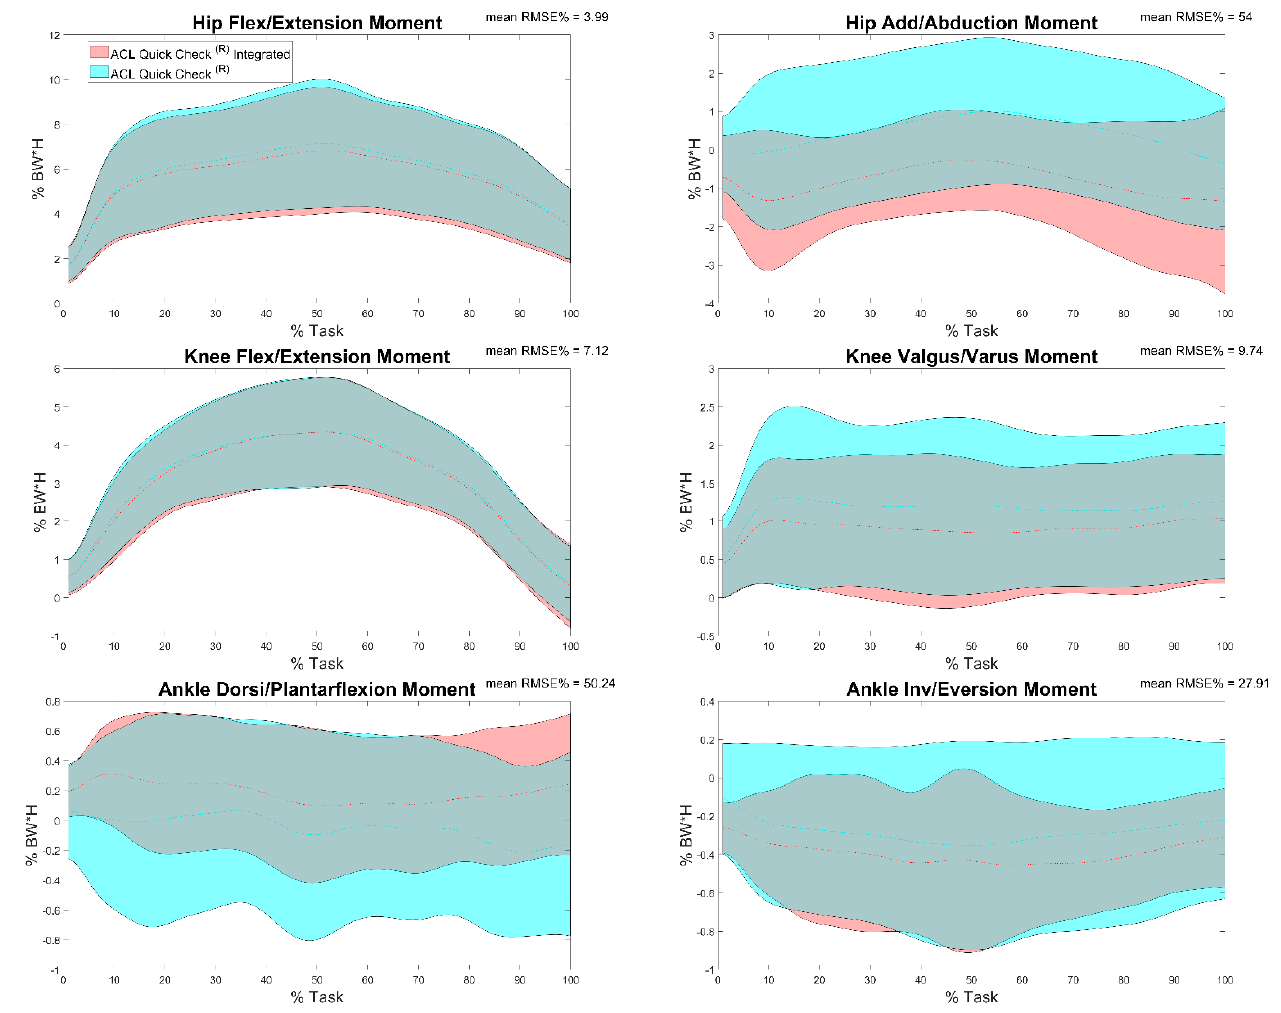
Figure 9. Hip, knee and ankle adduction/abduction and flexion/extension moments during the task calculated through ACL Quick Check ® (cyan) and through ACL Quick Check ® integrated (red) and mean of RMSE% of the comparison between the two. Averages plus and minus one standard deviation are reported as colored bands.